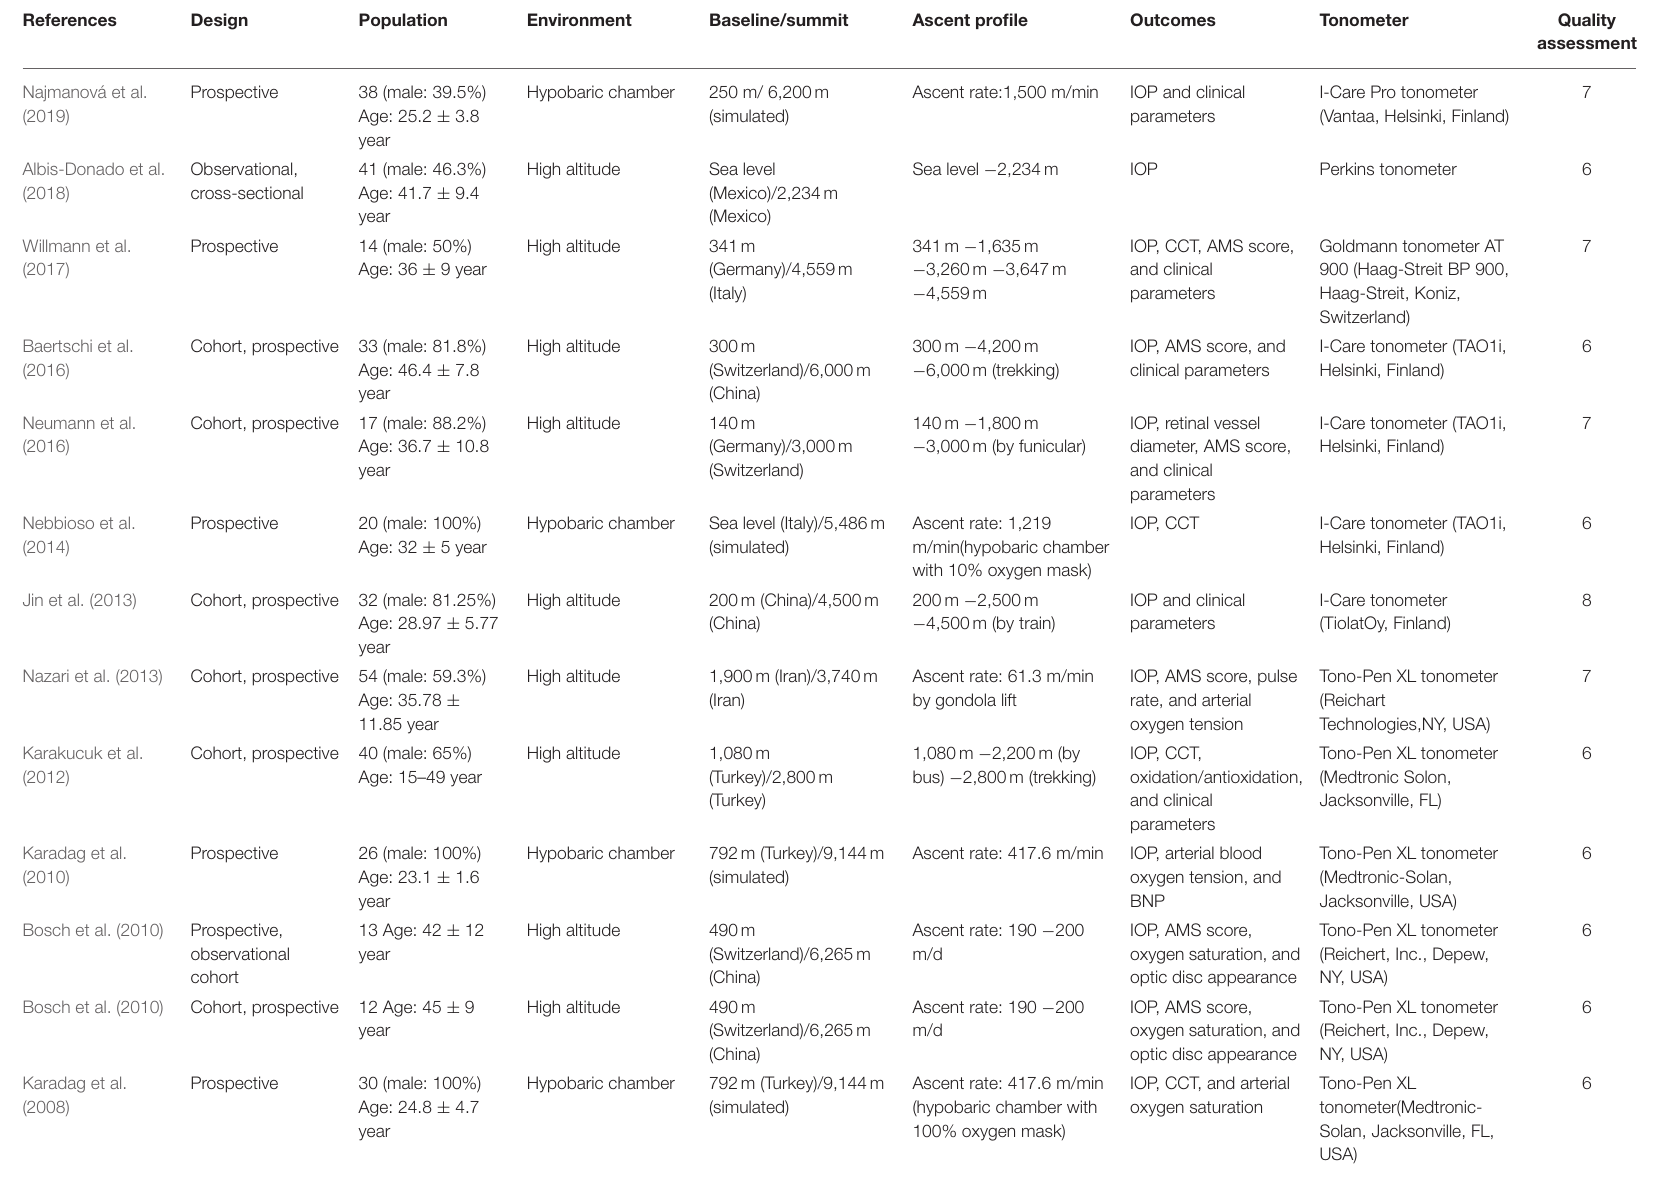
TABLE 1 | Information abstracted from 19 eligible